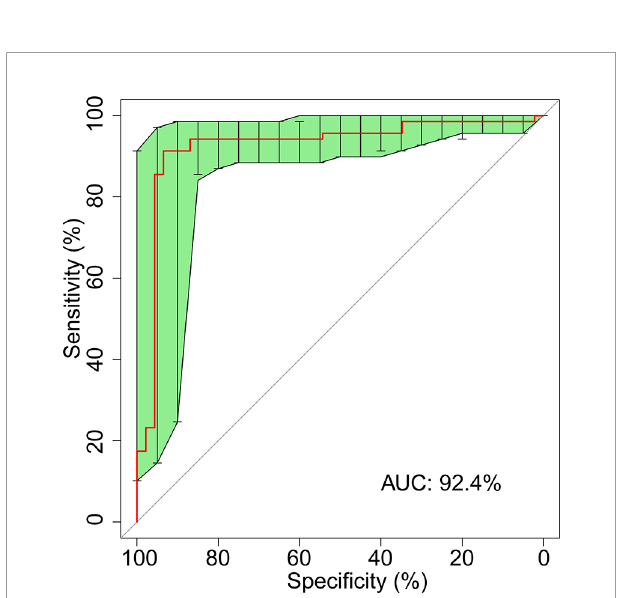
FIGURE 5 | ROC curve for 12 fecal microbial markers plus